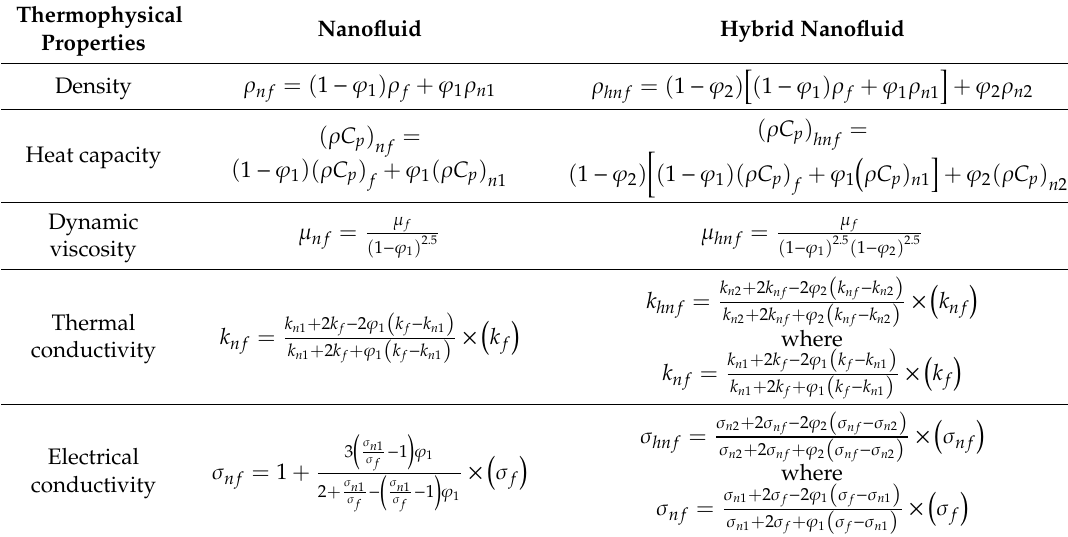
Table 1. Thermophysical properties of nanofluid and hybrid nanofluid.